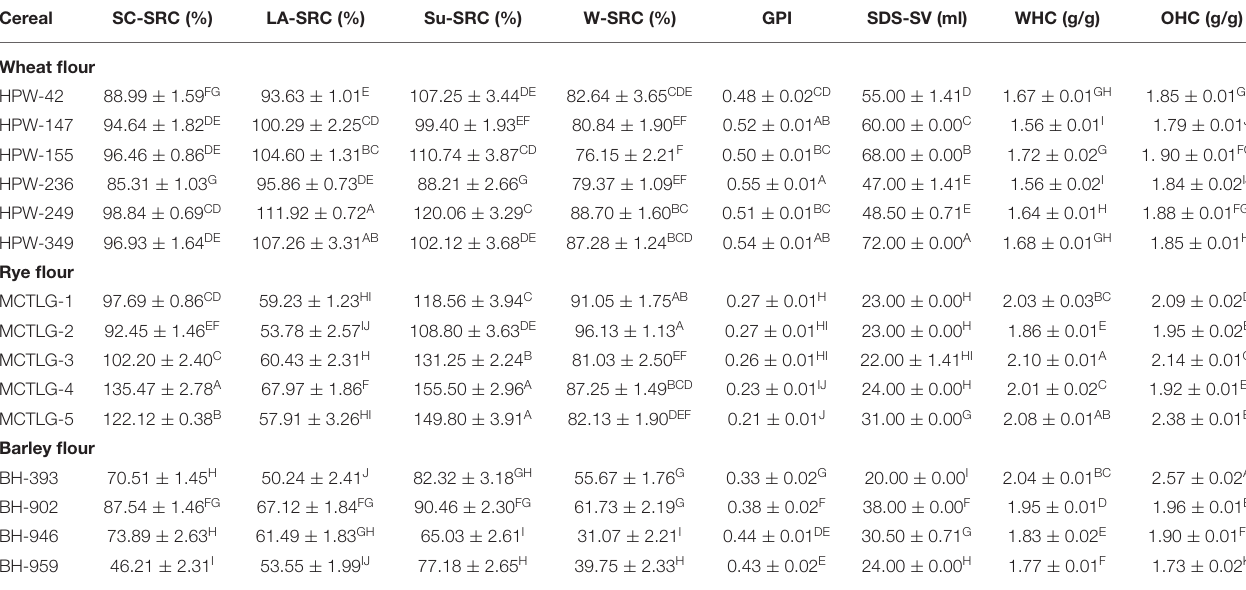
TABLE 4 | The solvent retention capacity (SRC) and flour performance properties of wheat, rye, and barley cultivars. Cereal SC-SRC (%) LA-SRC (%) Su-SRC (%) W-SRC (%) GPI SDS-SV (ml) WHC (g/g) OHC (g/g) Wheat